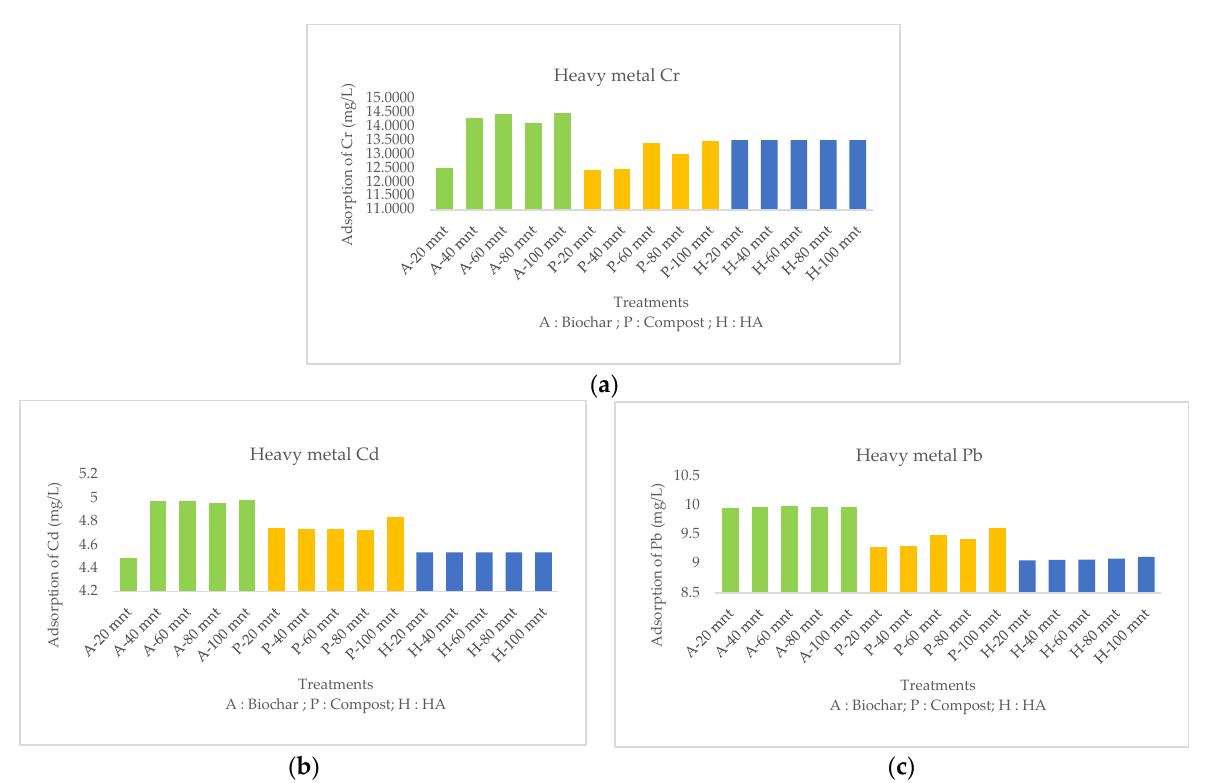
Figure 5. The adsorption of heavy metals Cr ( a ), Cd ( b ) and Pb ( c ) at various contact times.